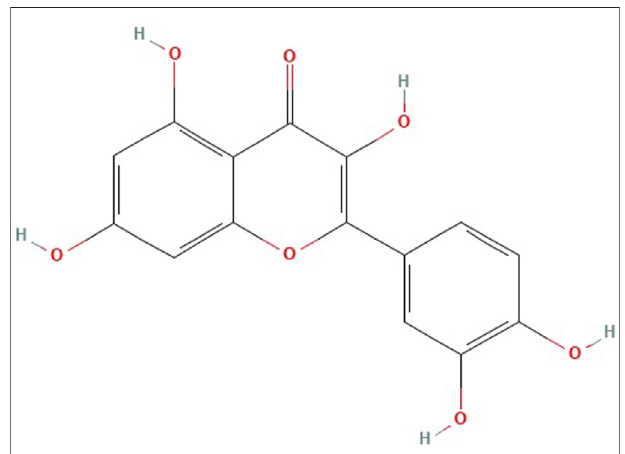
FIGURE 1 | Chemical structure of